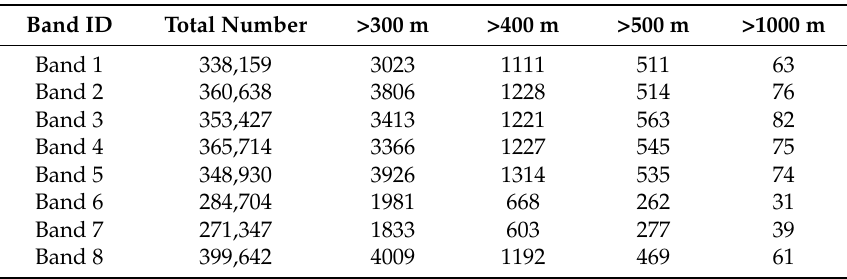
Figure 6. The detected lines with length greater than 300 m extracted from Band 8 using the vertical direction gradient data with a resolution of 15 m as input images. The black lines are detected lines, and the red lines are manual interpreted tidal cracks. Table 4. Numbers of detected lines with different lengths using the vertical direction gradient data with a resolution of 15 m.